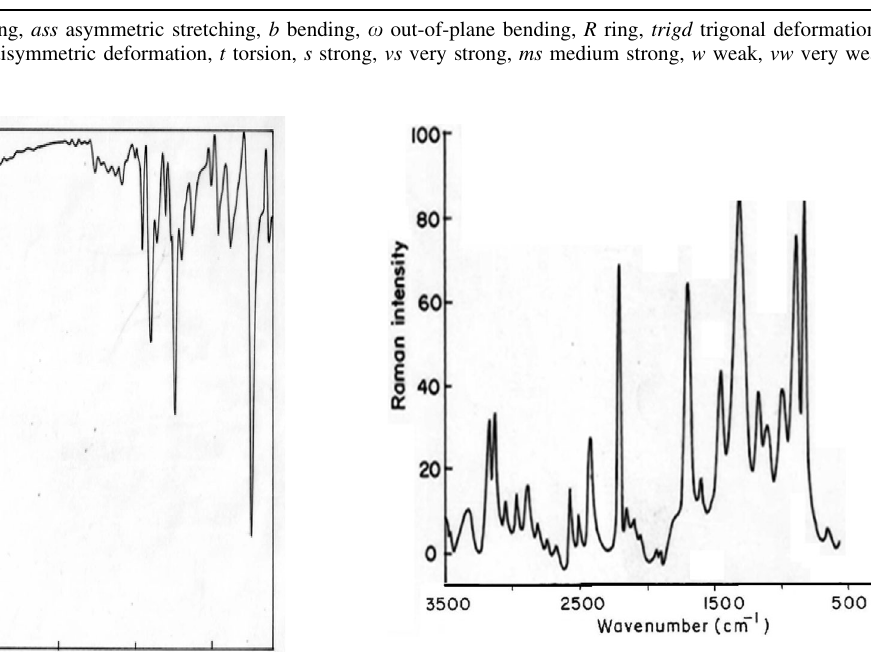
Fig. 6 Experimental FT-Raman spectra of